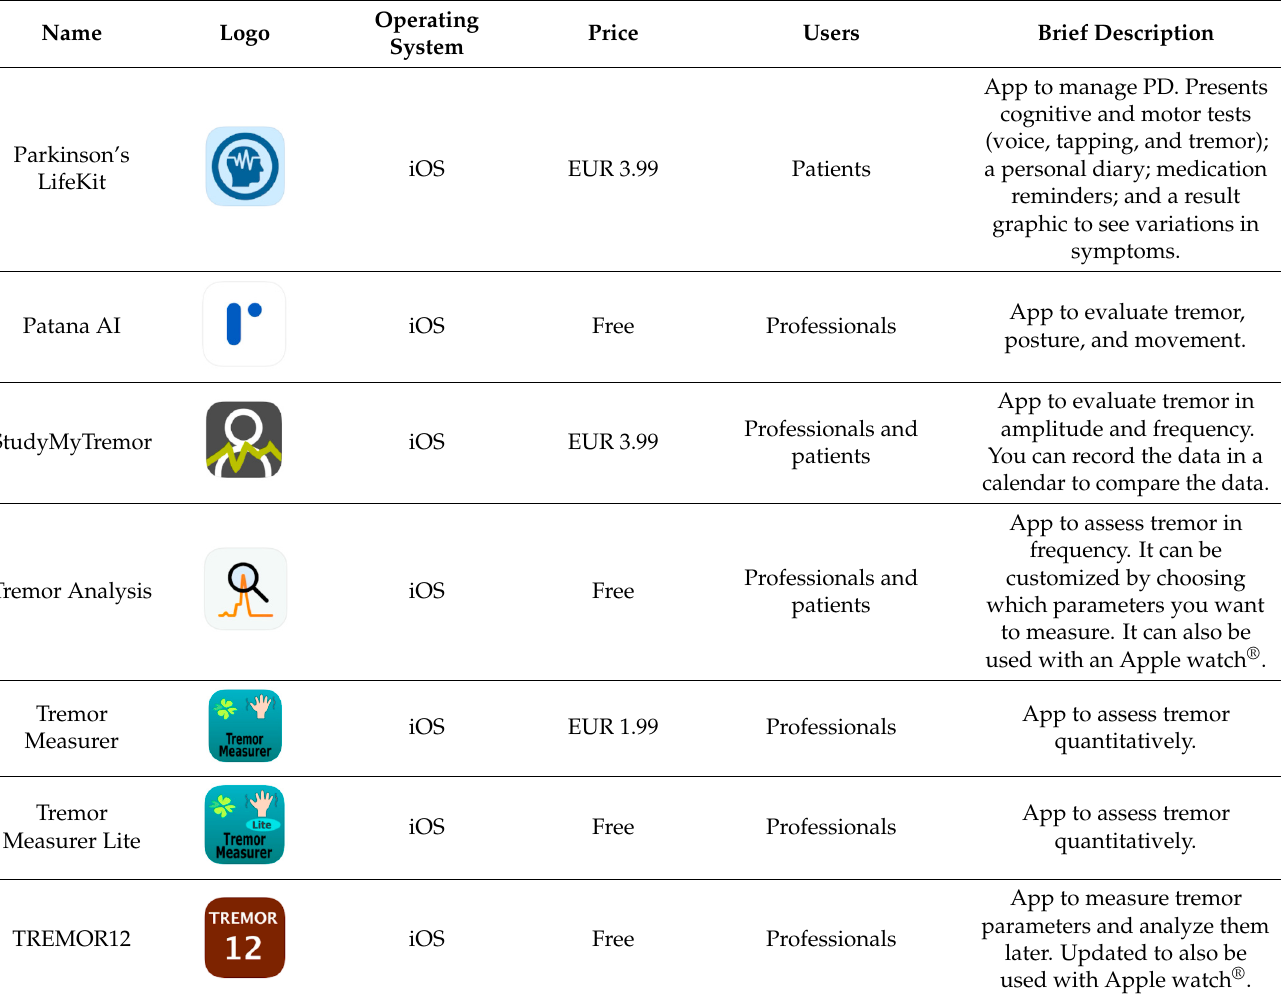
Logo Operating System Price Users Brief Description cloudUPDRS